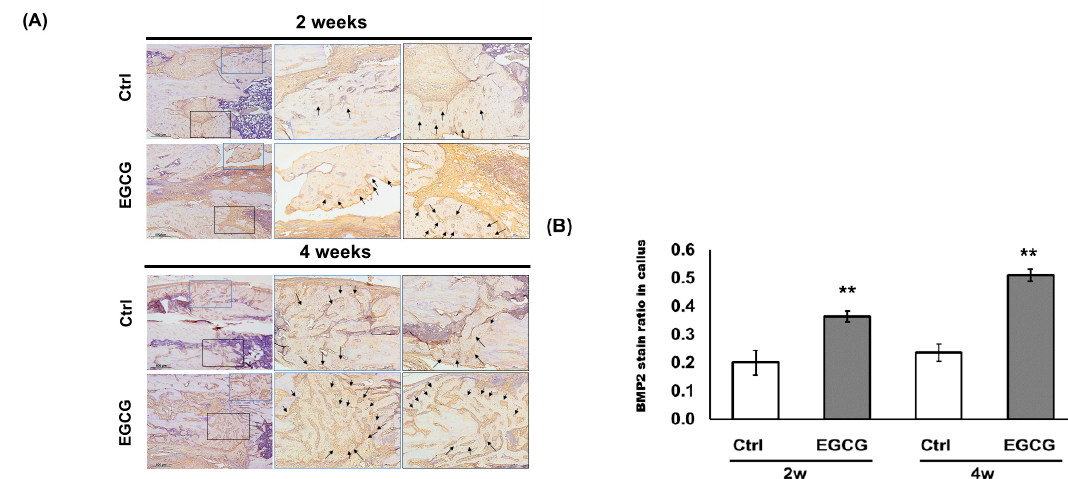
Figure 4. Immunohistochemistry study. ( A ) Immunolocalized bone morphogenetic protein-2 (BMP-2) in new form matrices were stained brown. The arrows indicate positive BMP-2 stains. ( B ) Quantification of immunolocalized BMP-2. EGCG facilitated bone fracture healing by increasing the BMP-2 expression in callus tissue. ** p < 0.01 versus control after treatment.